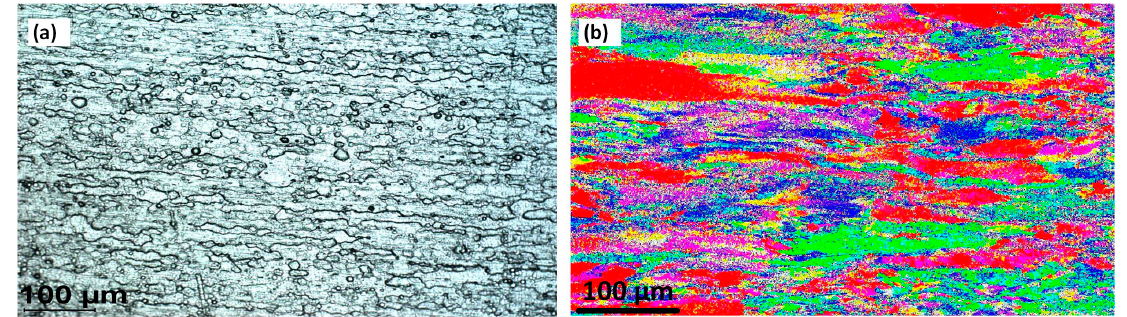
Figure 4. Base Metal microstructure, ( a ) Optical microscopy and ( b ) EBSD colour map.